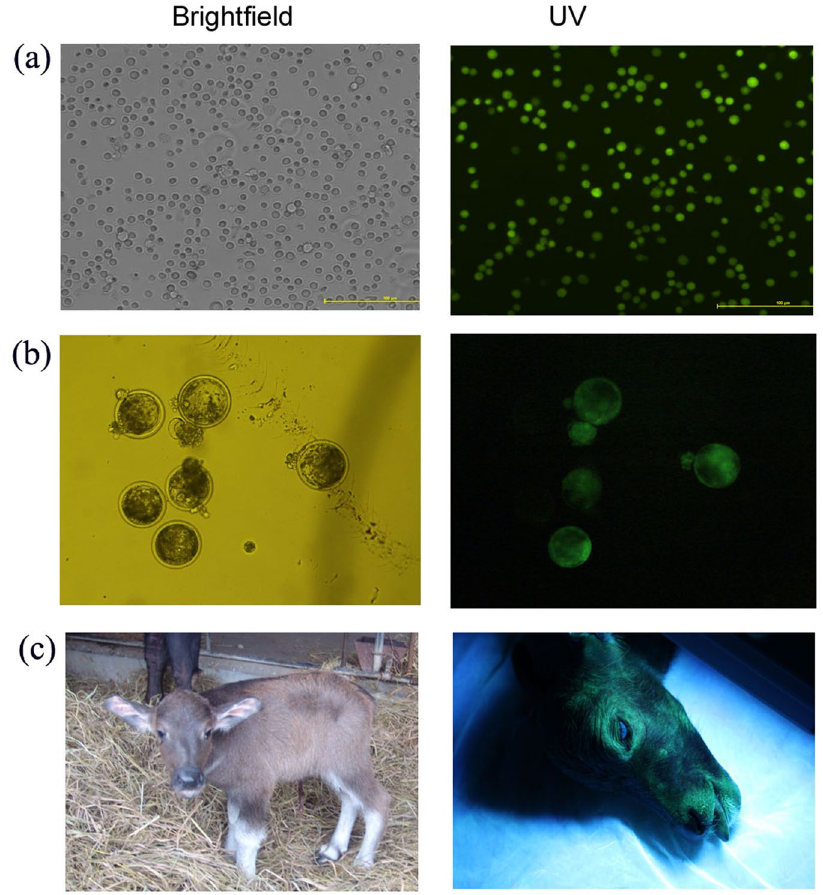
Figure 2. Expression of EGFP in transgenic BFFs ( a , 200 × ), SCNT blastocysts ( b , 100 × ) and SCNT calf ( c ).